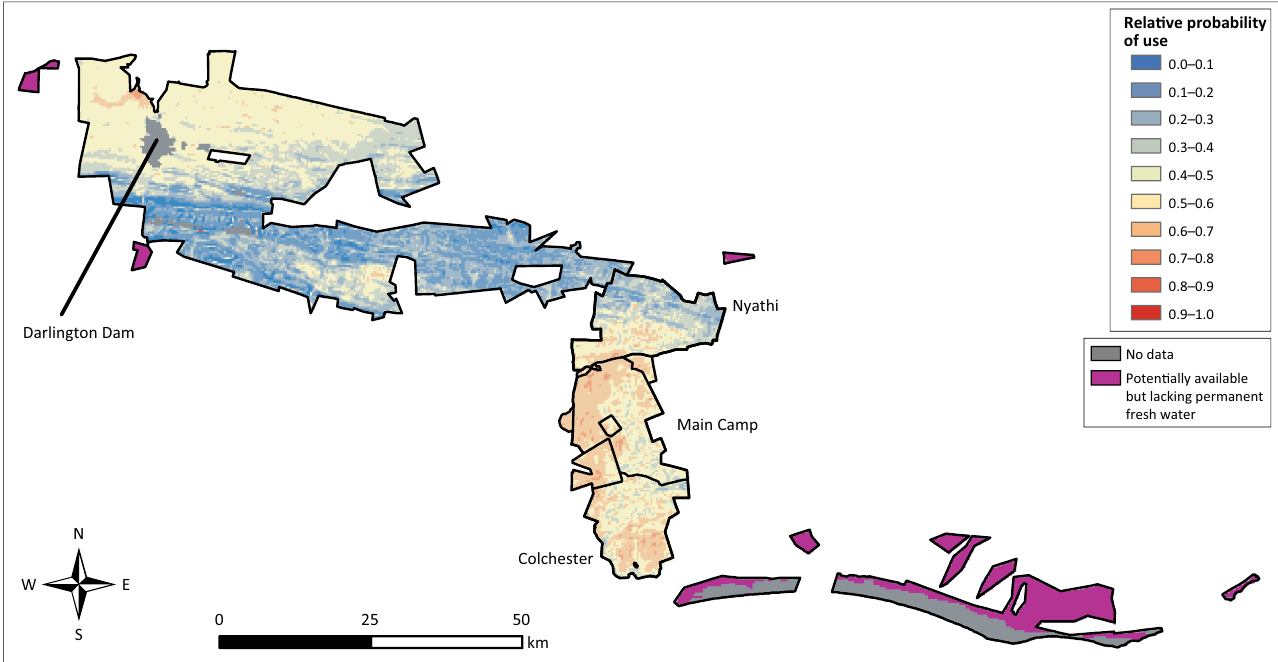
FIGURE 5: Relative probability of use by elephants across Addo Elephant National Park. The map reflects the predicted relative probability of use based on the midday (12:00) step selection function model, averaged across the 70 sixteen-day periods corresponding to the Moderate Resolution Imaging Spectroradiometer composites used in this